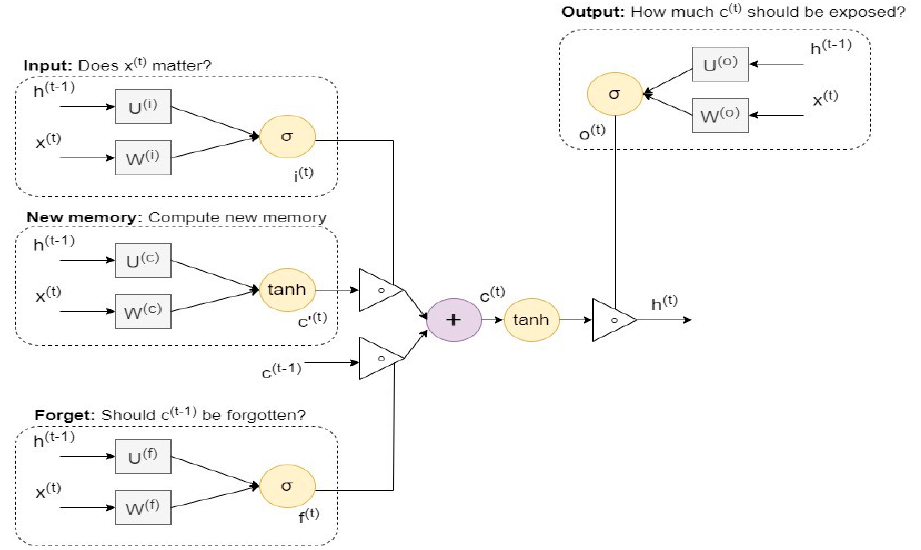
Figure 5. The structure of the LSTM technique.